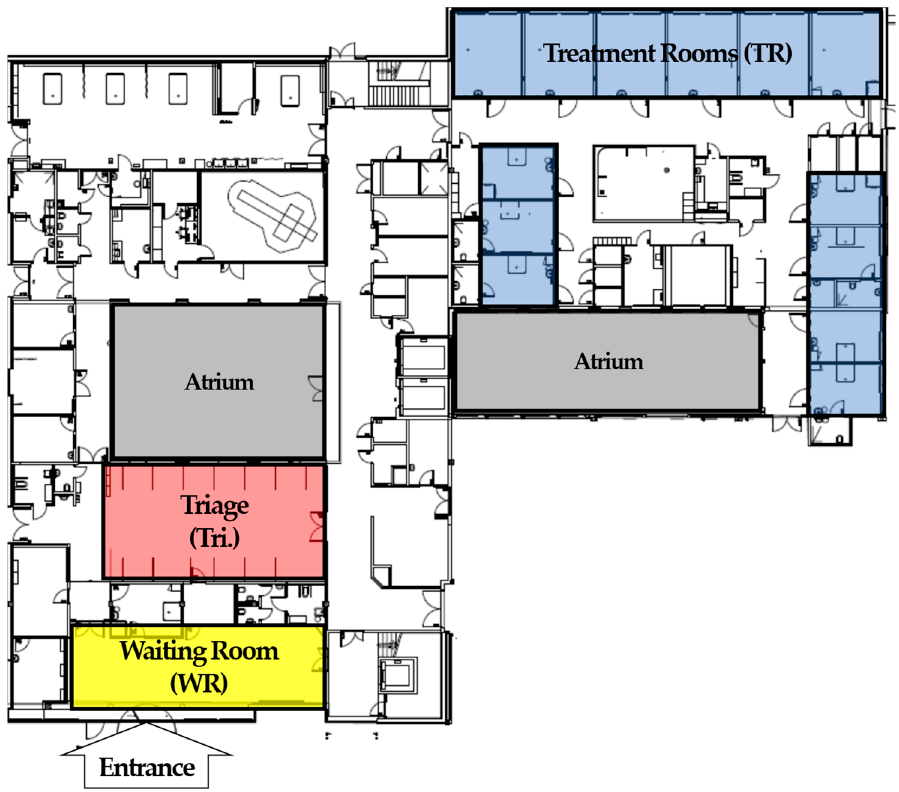
Figure 3. The blueprint of the studied ED prior to the onset of the COVID-19 pandemic. Entrance marked in green, waiting room in yellow, and treatment rooms in blue.